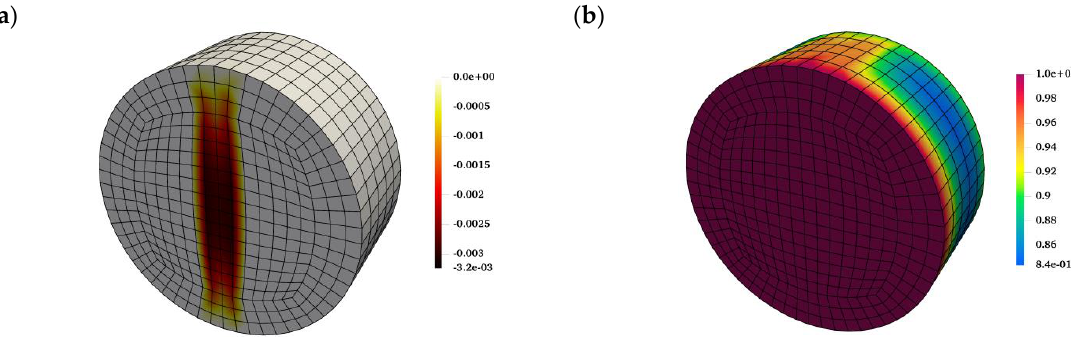
Figure 4. Distribution of ( a ) outflow flux ( mm/s ) and ( b ) pore-fluid pressure ( MPa ) at the vertical displacement of 50.5 μm (final stage).